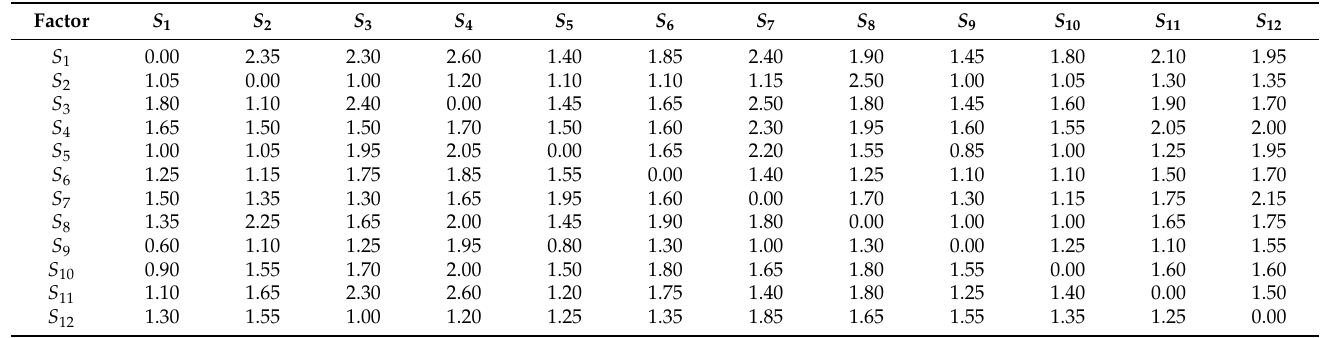
Table 3. Direct influence matrix T for influencing factors of job